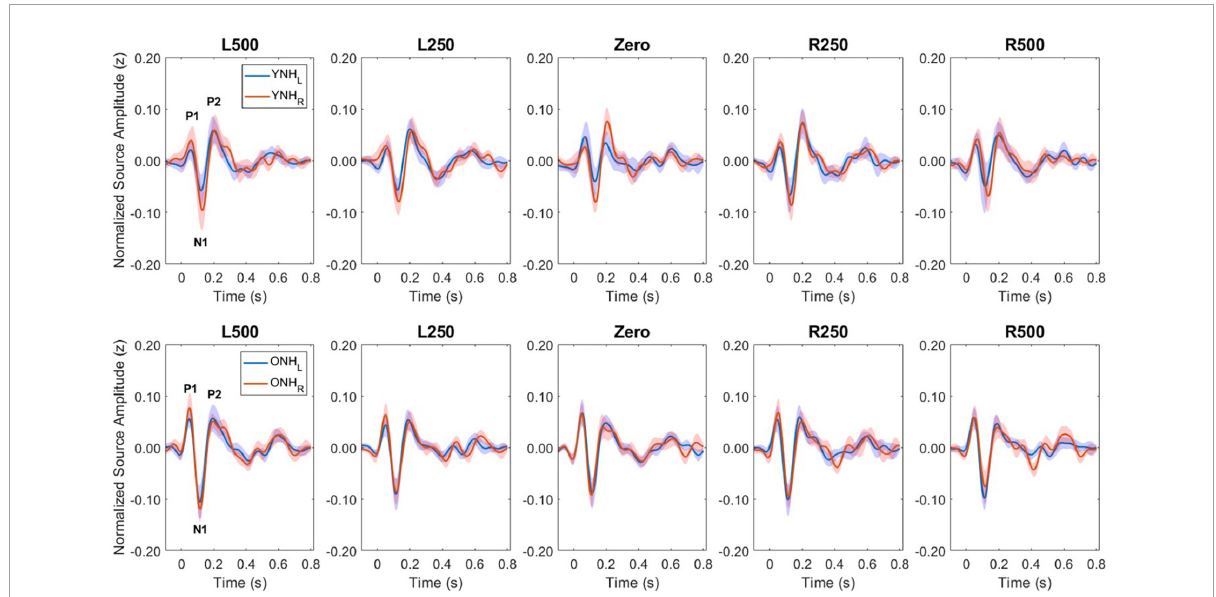
FIGURE5 Grand average source-localized evoked responses from left (LH) and right (RH) hemisphere regions of interest (ROIs), for each interaural time difference (ITD) condition and each listener group (YNH, top row ; ONH, bottom row ). The three main peak components (P1, N1, P2) are labeled in first panel of each